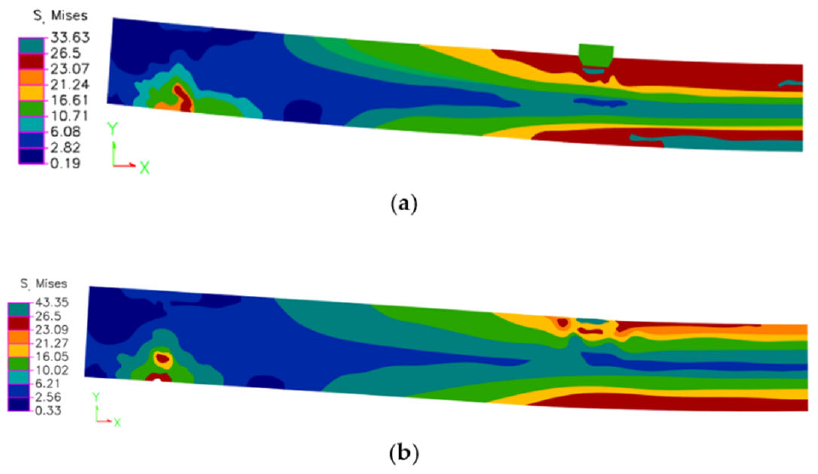
Figure 5. Mises stresses in MPa: ( a ) beam with no reinforcement; ( b ) reinforced beam. Reinforced beams initially fail in the tensile zone and then crush in the compression zone